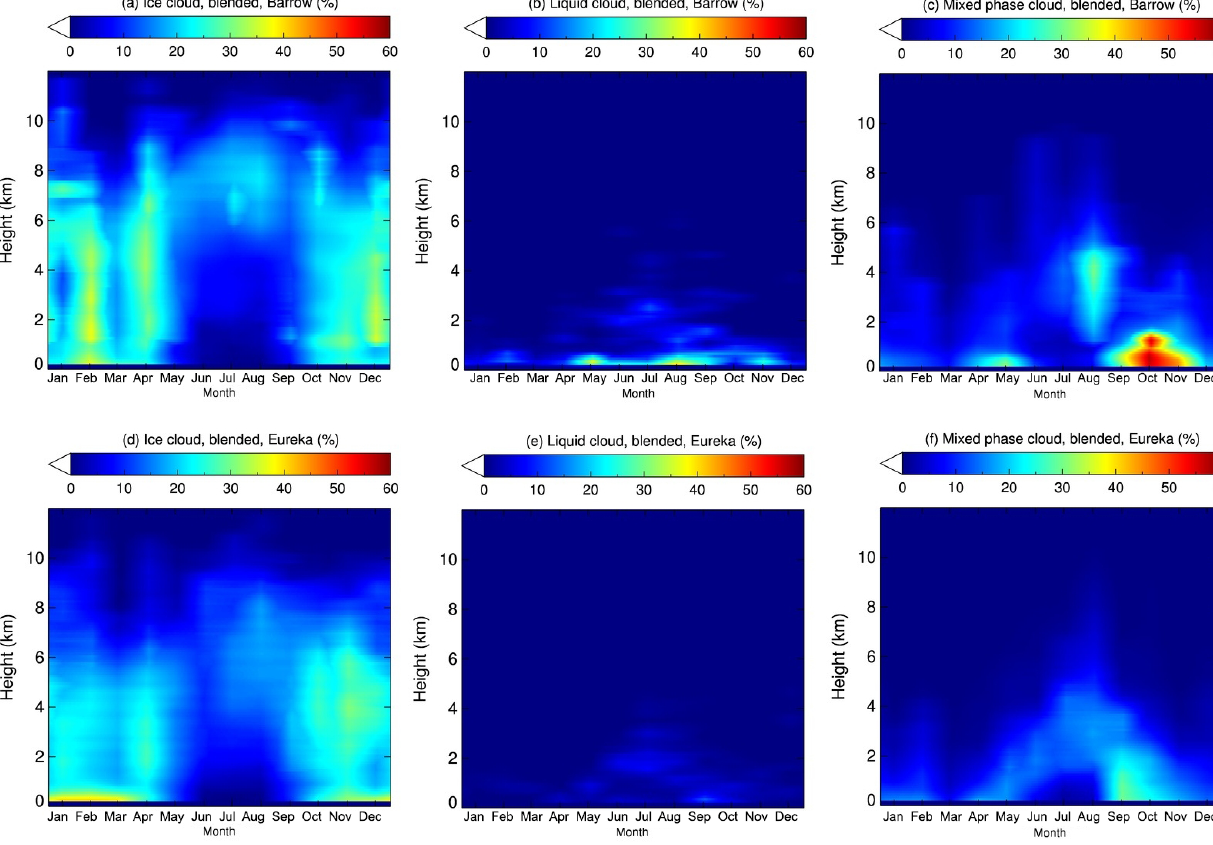
Figure 11. Blended vertical distributions of (a) ice phase clouds, (b) liquid phase clouds, and (c) mixed-phase clouds at Barrow, and (d) ice phase clouds, (e) liquid phase clouds, and (f) mixed-phase clouds at Eureka from 2B-CLDCLASS-lidar and surface observations for 2006–